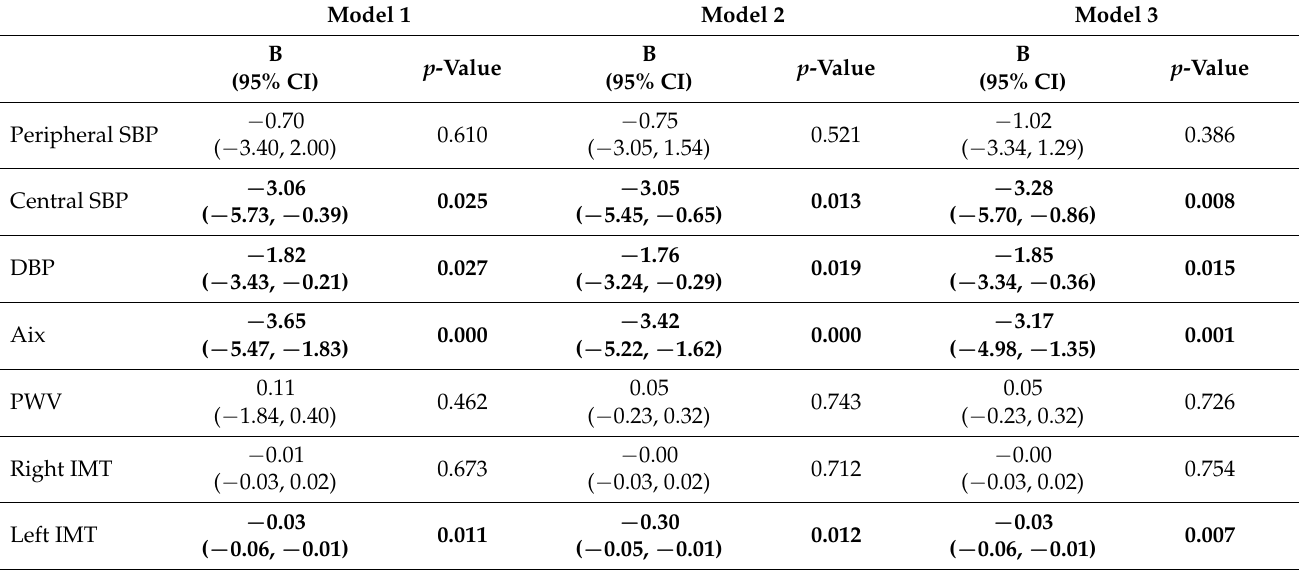
Table 4. Associations between subclinical vascular biomarkers and systematic breakfast consumption.